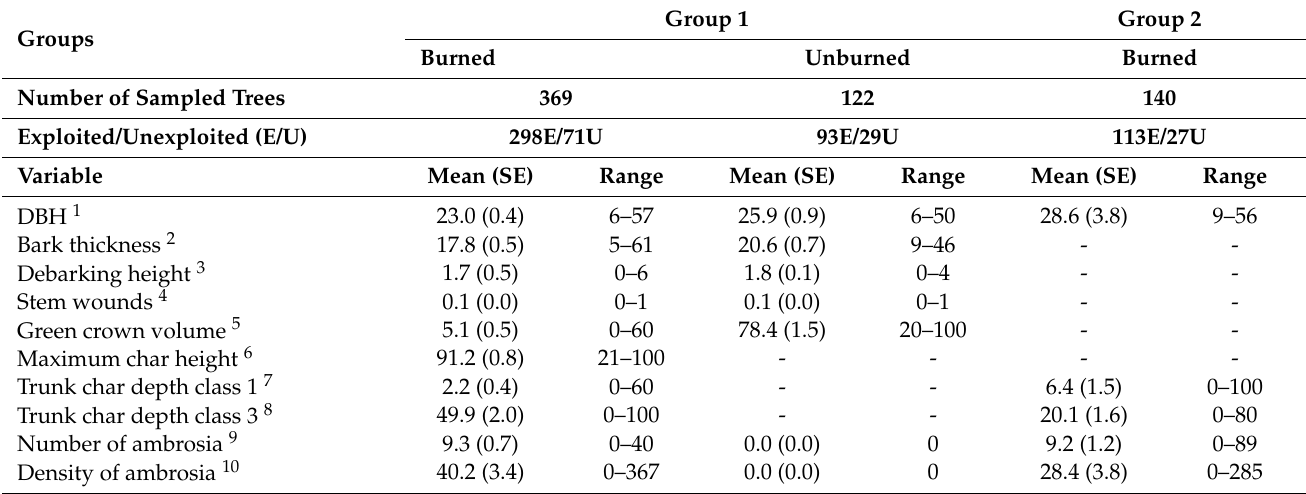
Table 2. Characteristics of the 631 cork oak trees sampled in groups 1 and 2.